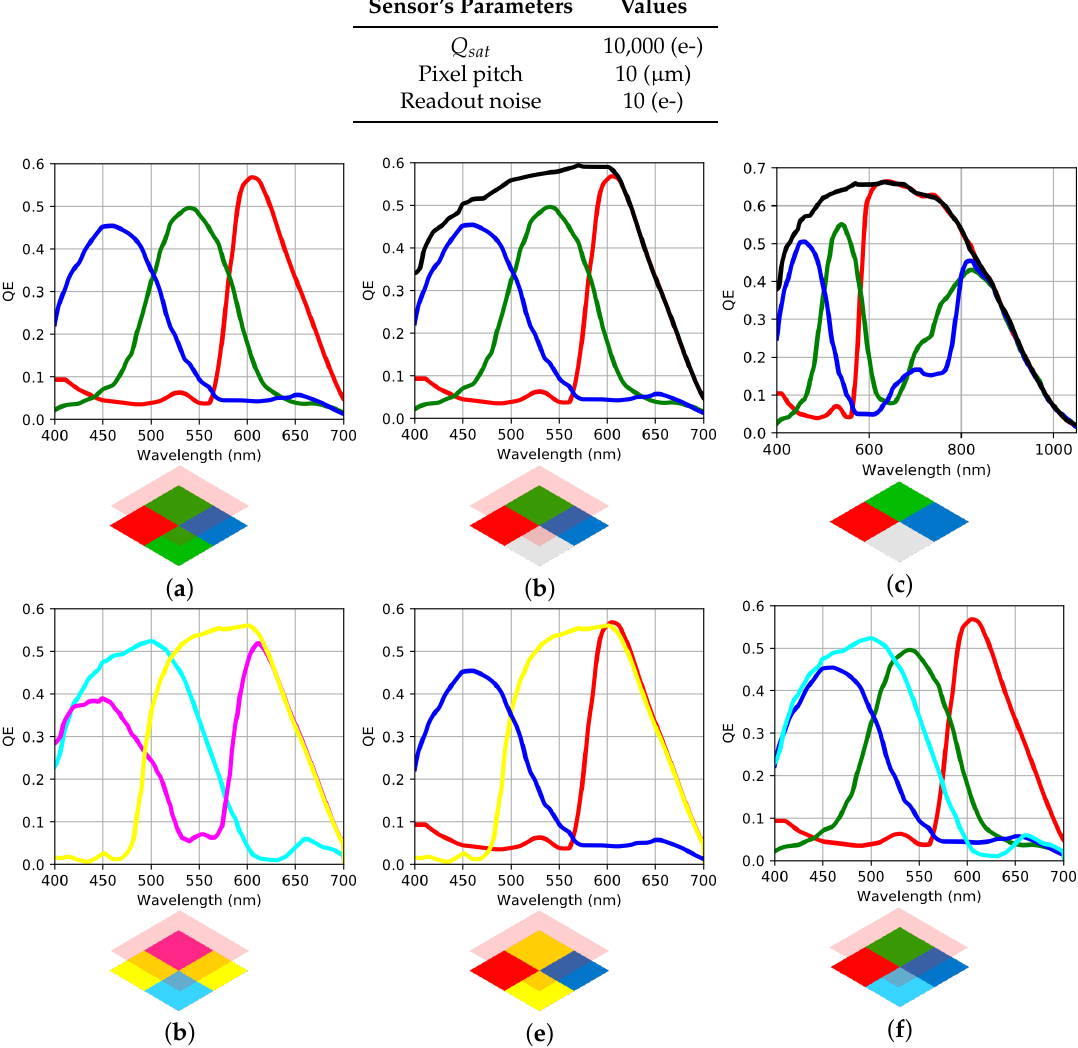
Figure 16. Spectral sensitivities of each sensor. Color code correspond to the nature of spectral sensitivity of the channels. ( a ) RGB, ( b ) RGBW, ( c ) RGBWir, ( d ) CMY, ( e ) RYB, ( f )